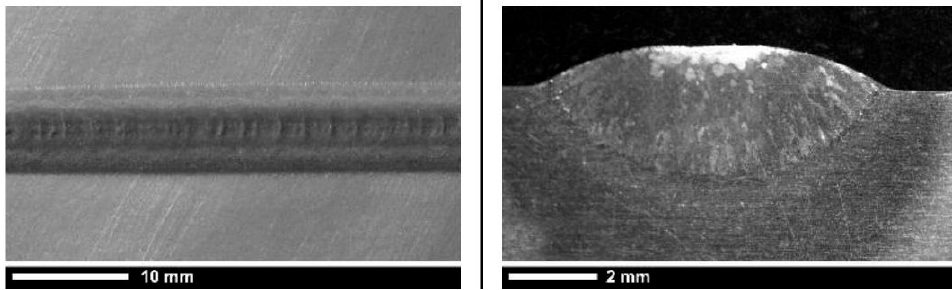
Figure 4. Deposited metal trace view and cross-section ( P = 3 kW, v = 200 mm/min, ṁ = 4 g/min). The characteristic geometrical parameters of the deposited trace cross-section were measured as indicated in Figure 5. The measurement values for each process condition are reported in (Table 2). Table 2. Measured values of the cross-section geometrical parameters for the three repetitions of the diverse experimental process conditions.